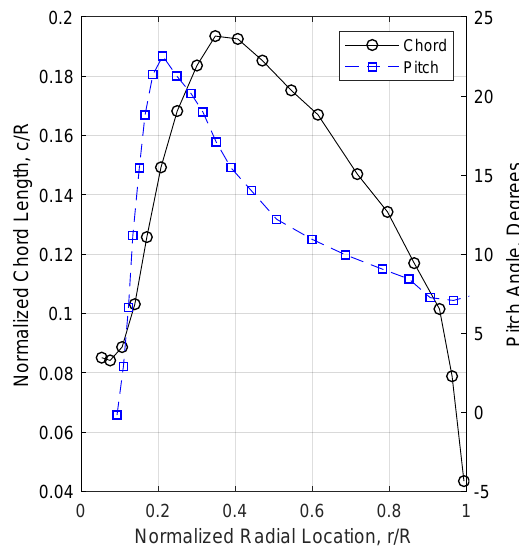
Figure 4. T-MOTOR 18x6.1 rotor geometry